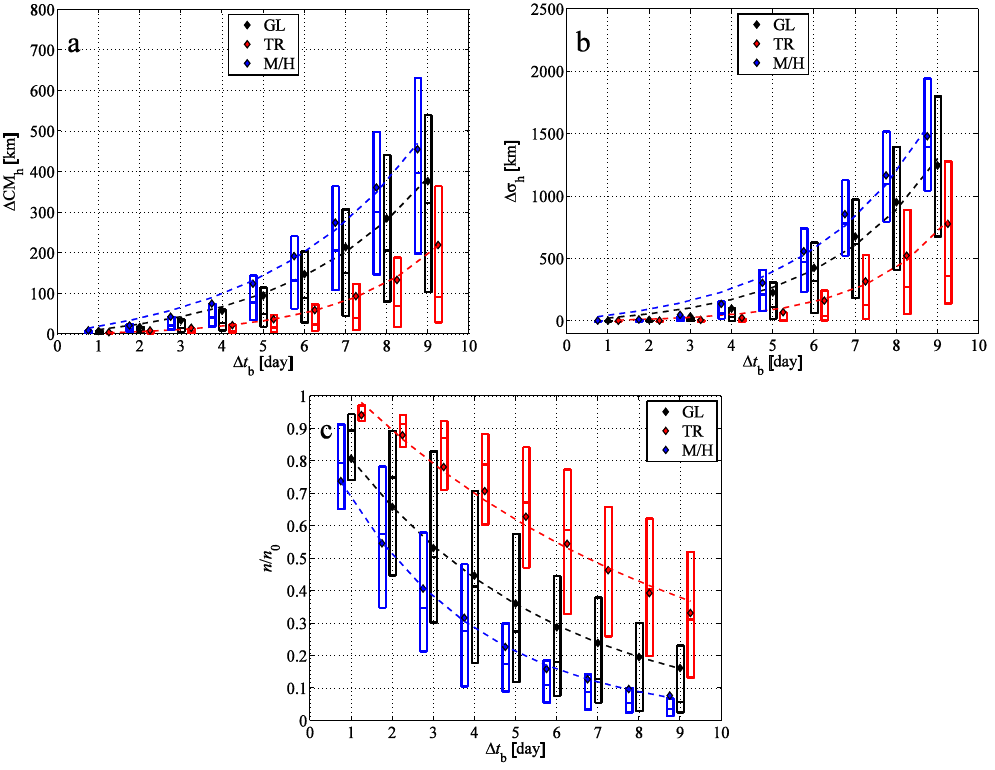
Figure 7. ( a ) The horizontal difference ∆ CM h between the center of mass of the BWCs and the FWC depending on the time period ∆ t b of the backward simulation; ( b ) the difference ∆ σ h between the horizontal standard deviations of the BWCs and FWC; ( c ) the proportion n / n 0 of the particles returned back to the initial cuboid. The results are shown for the tropical region (TR, red), for mid- and high latitudes (M/H, blue) and for the globe (GL, black). Mean values (diamonds), medians and lower and upper quartiles (boxes with horizontal lines) are indicated. Dashed lines indicate exponential fits to the mean values; the exponents are given in Table